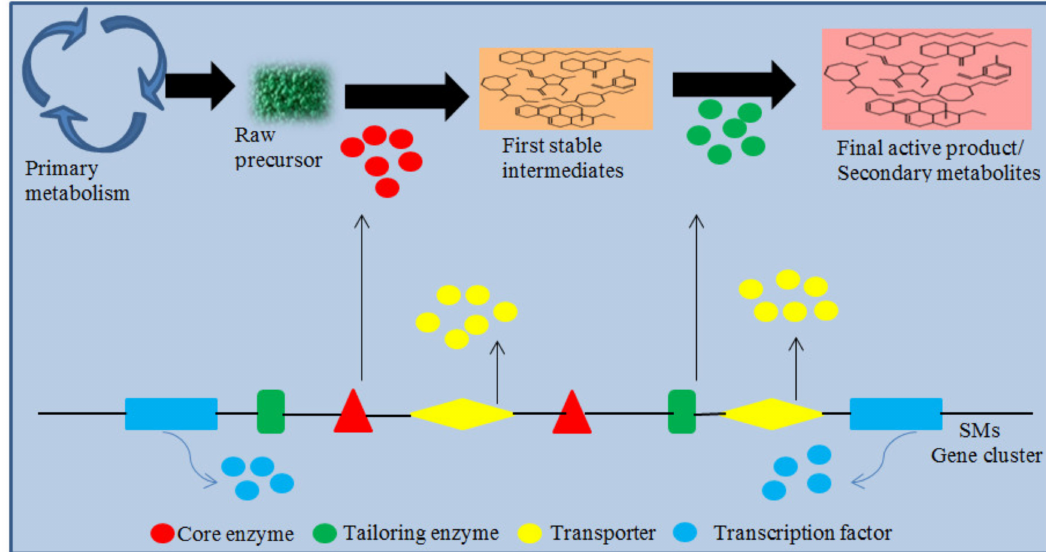
Figure 14. Proposed biosynthetic scheme and the regulation factors of SMs in Trichoderma